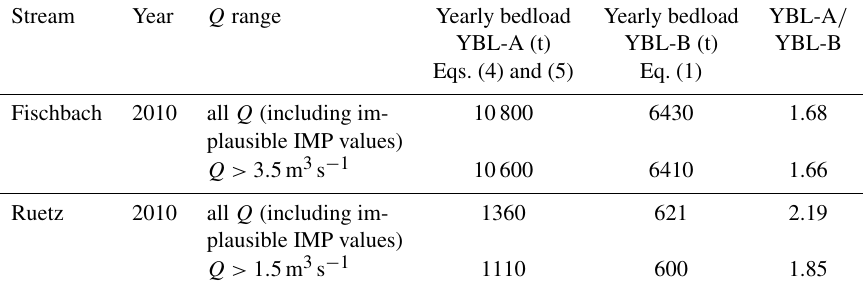
Table 4. Comparison of yearly bedload (YBL, in t) calculated with two different calibration relations, for the year 2010 and for different ranges of Q values. The YBL values represent transport over the entire stream width; as only every second steel plate is equipped with a geophone sensor, the loads inferred from the geophone impulses were multiplied by a factor of 2 in this table. Stream Year Q range Yearly